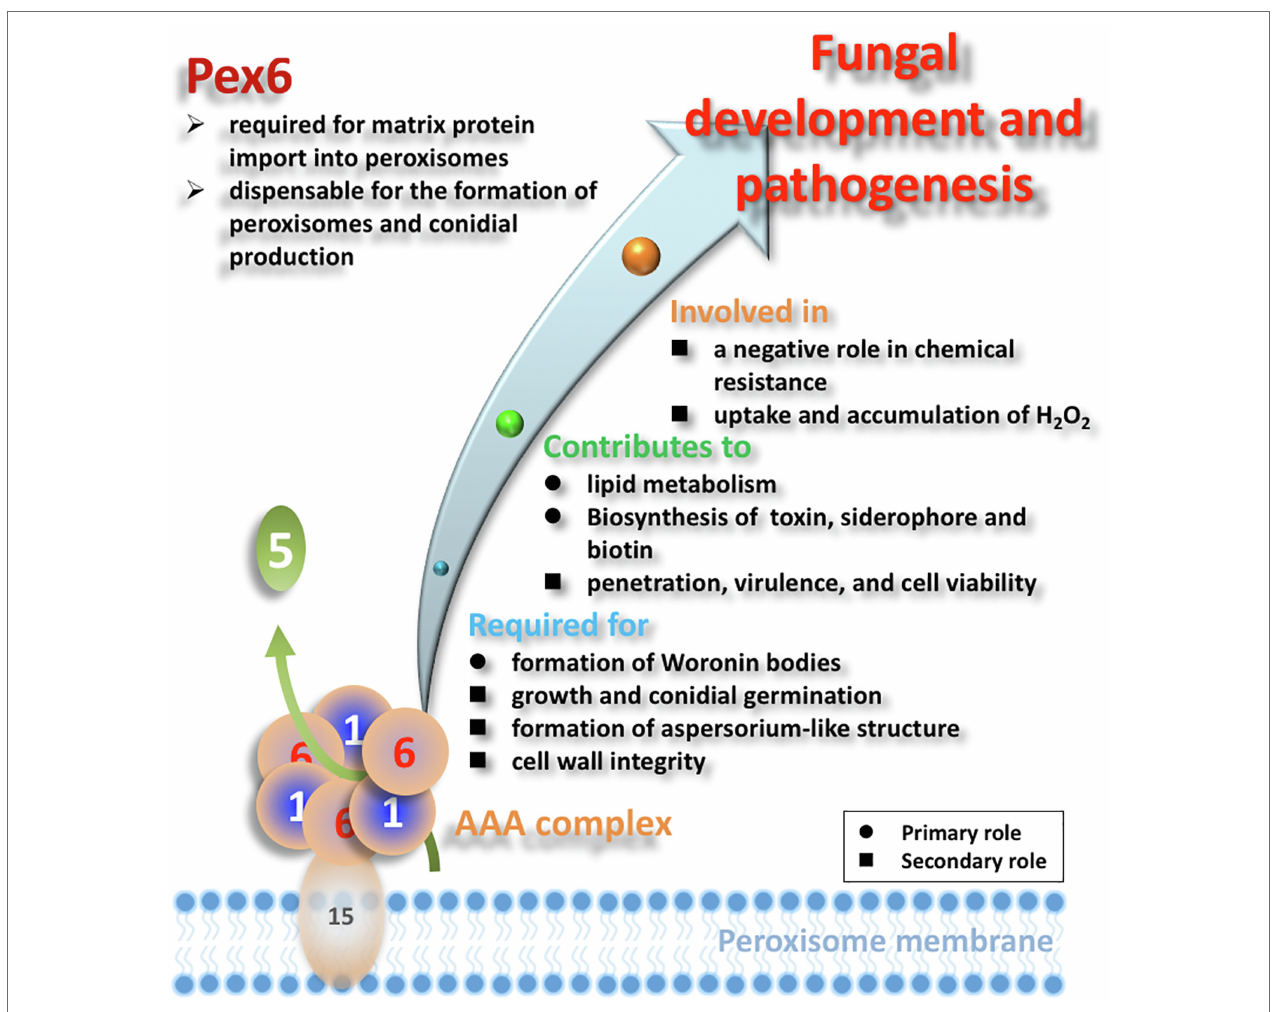
FIGURE 12 | Schematic illustration of the overall functions of Pex6 in A. alternata. Matrix proteins are presumably imported by a Pex5 receptor, and the Pex1/Pex6 AAA complex attached to membrane via Pex15 is involved in recycling the receptor proteins. Black circle ( ● ) and black square ( ■ ) indicate the primary and secondary roles of peroxisomes,